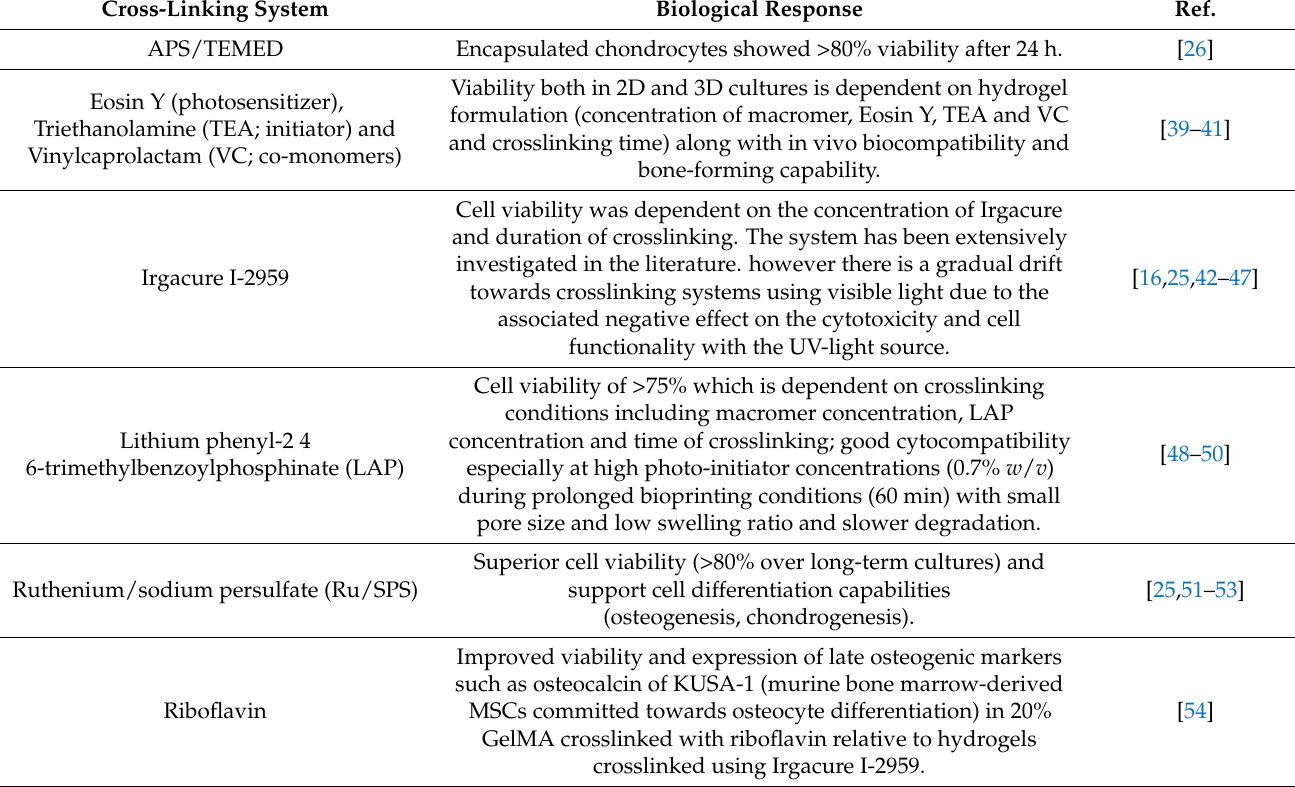
Table 1. Different crosslinking systems used for polymerizing